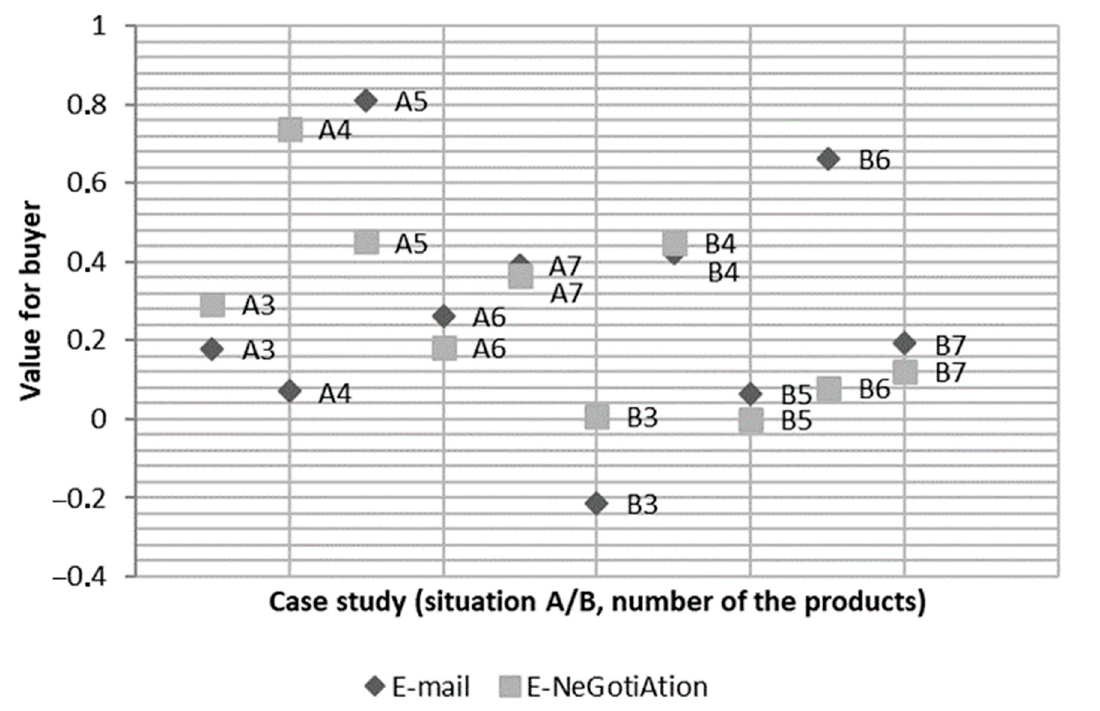
Figure 6. The ratio of total compensation and total sales price for the